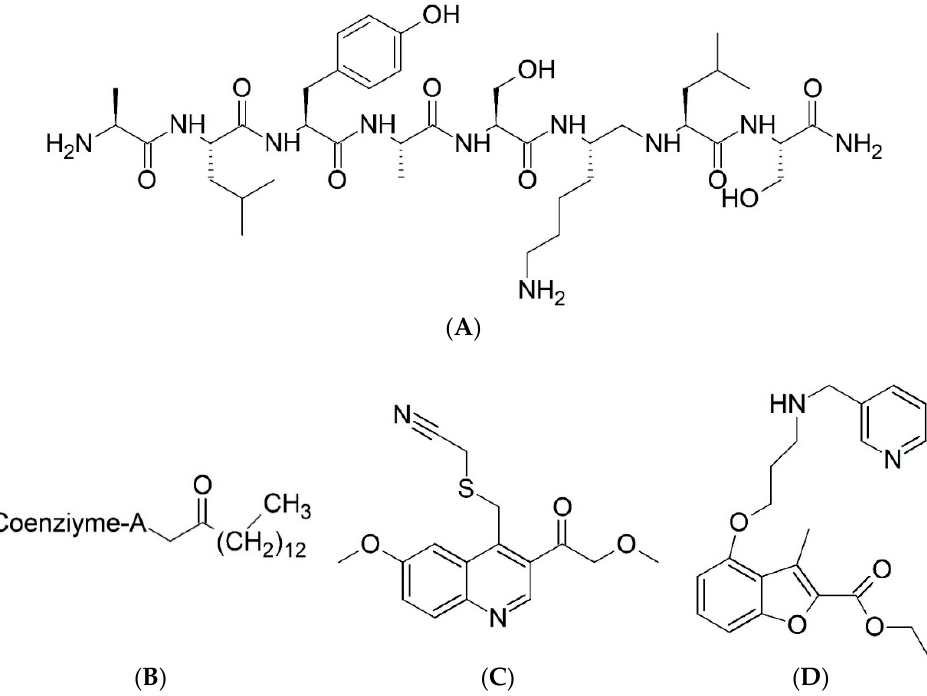
Figure 1. ( A ) Inhibitor mimicking the structure of substrates ( Ki = 5.0, 8.0, and 35.0 μ M for S. cerevisiae